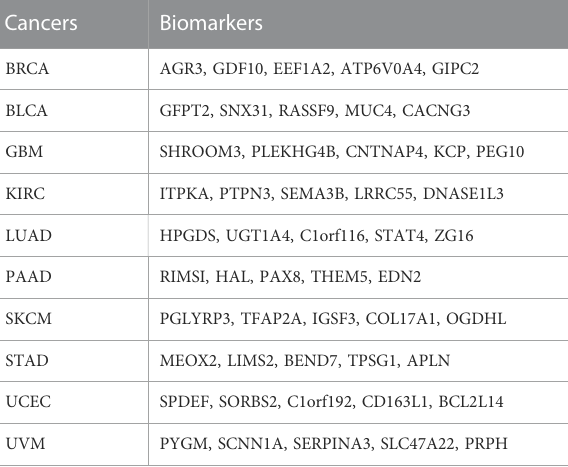
TABLE 9 The fi ve biomarkers most relevant to ten cancers.